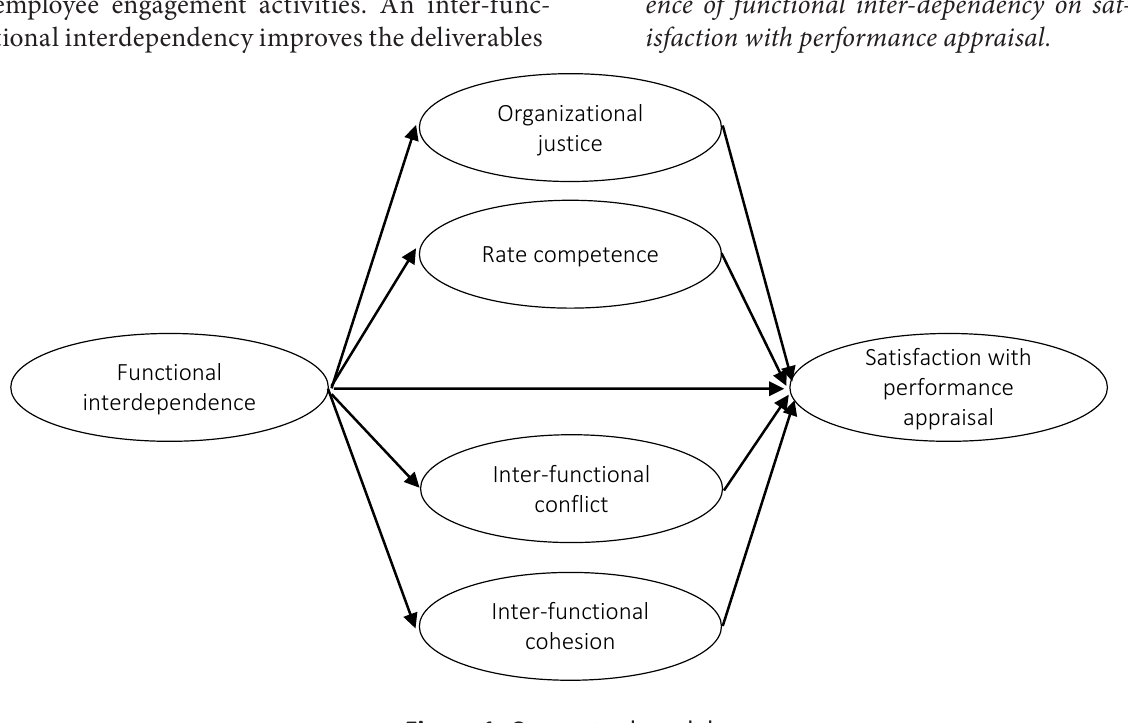
Figure 1. Conceptual